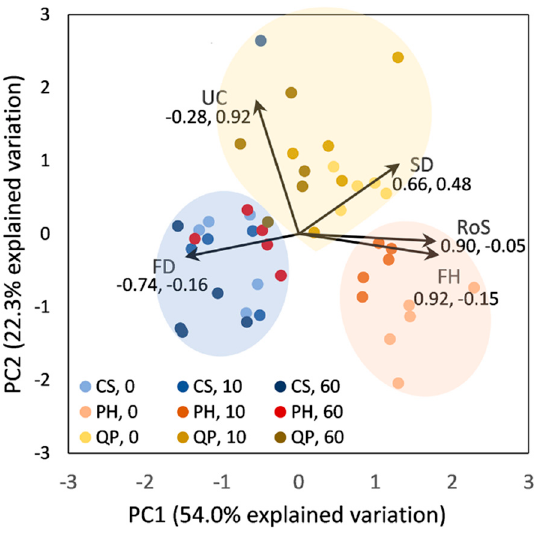
Figure 1. Results of the principal component analysis (PCA) and k-means cluster analysis. Note: Each data point represents an individual sample. Species and treatment combination are color coded. Species abbreviations: CS = Ceratonia siliqua , PH = Pinus halepensis , and QP = Quercus pubescens . Treatments are indicated as defined in the material and methods section. Individual parameters included in the PCA are: rate of spread (RoS), flaming duration (FD), smoldering duration (SD), flame height (FH), and percentage of the fuel remaining upon combustion—unconsumed (UC). Arrows graphically present the loadings of the individual parameters to PC1 and PC2. Exact loading values are given underneath the abbreviations of individual parameters (left—PC1 loading, right—PC2 loading). Clusters are indicated by colored shading.